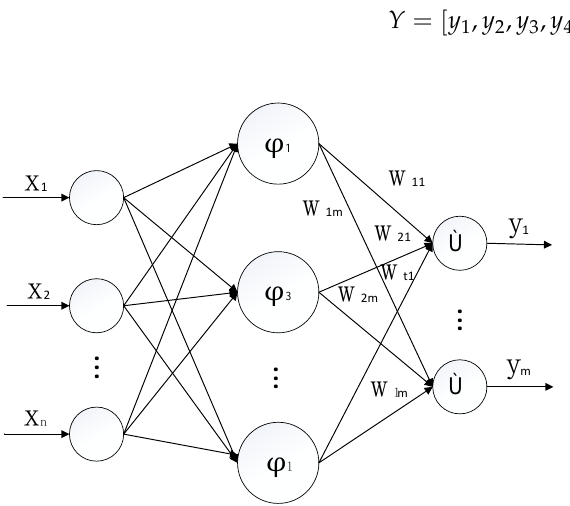
Figure 2. Structure of RBF neural network.